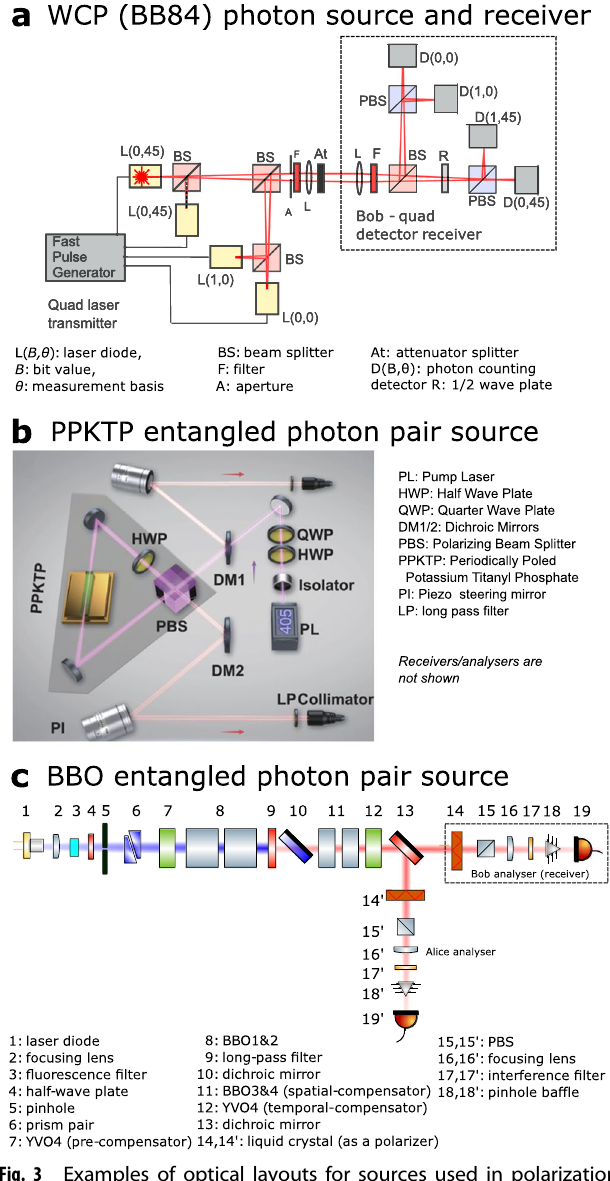
Fig. 3 Examples of optical layouts for sources used in polarization encoded DV-QKD designed for satellite QKD. a A weak coherent pulse source for BB84 QKD (adapted from ref. 120). b A polarization- entangled photon-pair source using PPKTP in a Sagnac loop arrangement (adapted from ref. 47) c A polarization-entangled photon-pair source based on BBO with Bell ’ s violation analysers (adapted from ref. 67), for BBM92 QKD these analysers would most likely be replaced with quad detector receivers as per